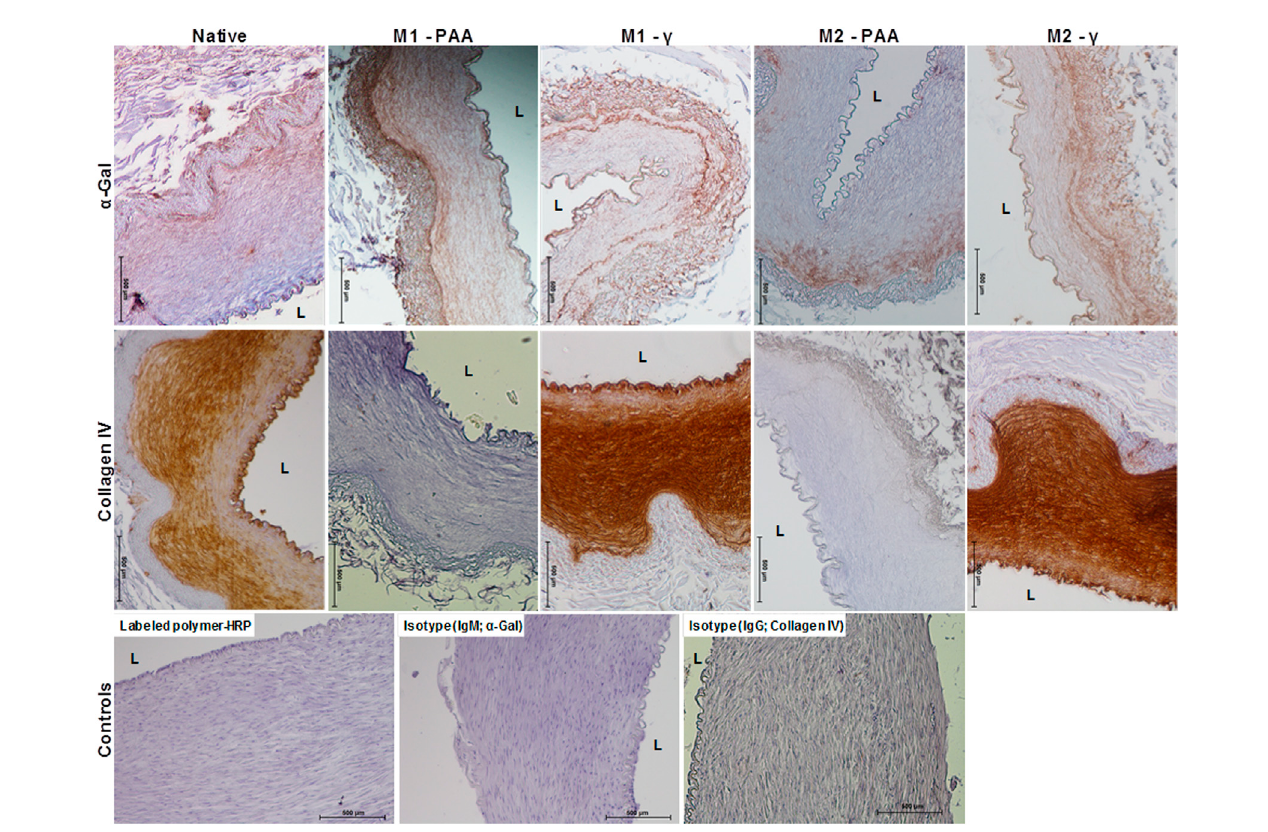
FIGURE 2 Immunohistochemical staining against α -gal and collagen IV of native PTA and decellularized PTA scaffolds treated with (M2) or without (M1) RNase/ DNase and sterilized with either PAA or γ -irradiation, also showing the HRP and isotype controls. Tissue positive against the α -gal epitope was stained light brown,whereastissuepositivetocollagenIVwasstaineddarkbrown.Alldecellularizedscaffoldsexpressed α -gal,albeitinareducedamountcomparedtothe native control.Collagen IVwasexpressed throughout themedia, intimaandbasementmembraneofthenativePTA andthedecellularizedPTAscaffolds thatweresterilizedwith γ -irradiation.NostainingagainstcollagenIVcouldbeobservedinthedecellularizedscaffoldsthatweresterilizedwithPAA.Scalebars indicate 500 μ